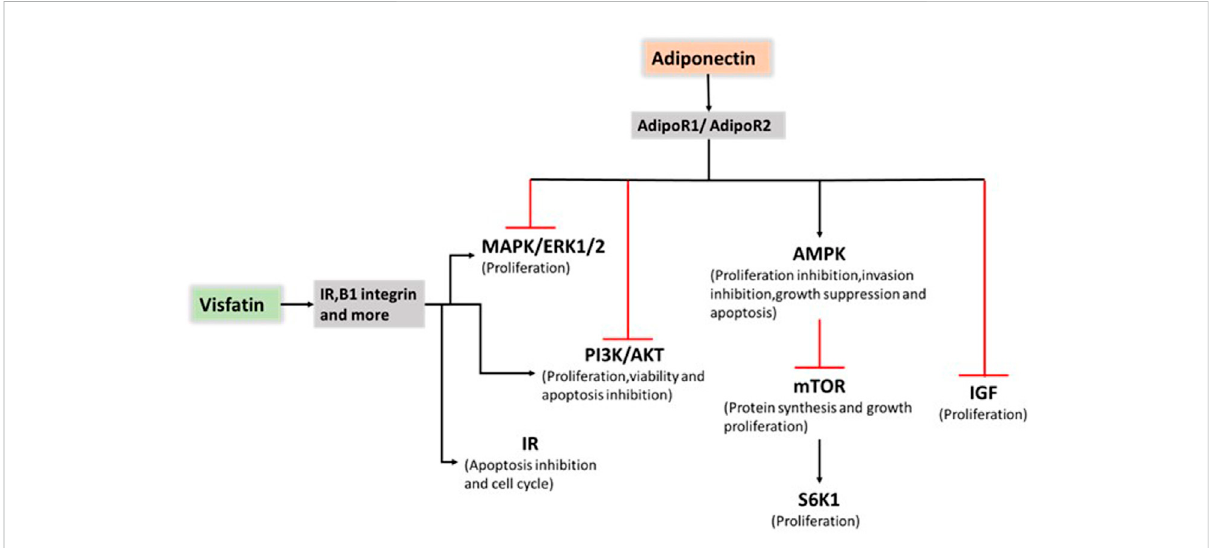
FIGURE 2 Role of adiponectin and visfatin in endometrial cancer progression. Adiponectin exerts an antiproliferative effect on endometrial cancer by stimulating AMPK pathway activation and suppressing PI3K/AKT, MAPK/ERK1/2 and IGF pathway activation. Visfatin promoted cancer progression mainly through PI3K/AKT, and MAPK/ERK1/2 pathway activation and IR. AMP: 5 adenosine monophosphate; AMPK: AMP-activated protein kinase; PI3K: phosphatidylinositol 3-kinase; AKT: the serine/threonine kinase; MAPK: mitogen-activated protein kinase; ERK1/2: extracellular signal- regulated kinases 1 and 2; IGF: insulin-like growth factor; IR: insulin